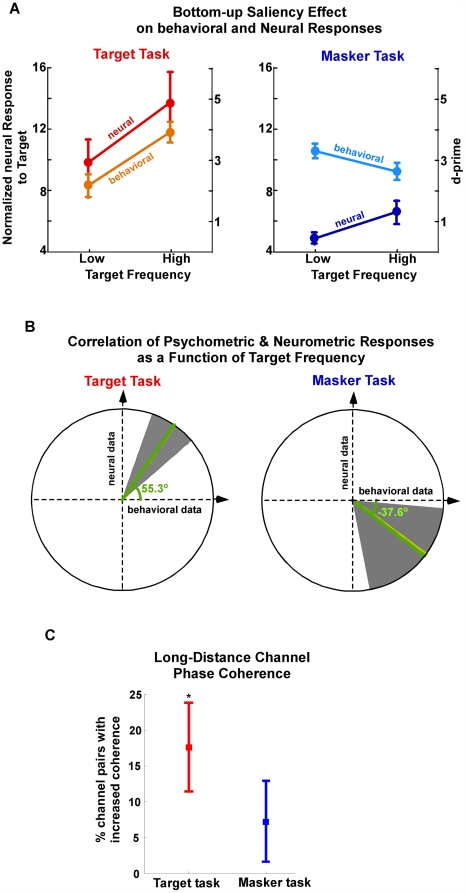
The effect of bottom-up acoustic saliency on behavior and neural responses.(A) Normalized neural response to target rhythm, and behavioral performance, as a function of target frequency in target task (left) and masker task (right), averaged over participants. Error bars represent standard error. (B) Correlation of behavioral and neural responses as a function of target frequency. The ratio of the neural to behavioral response differences as a function of target frequency, interpreted as a slope angle, is averaged across participants yielding a mean slope angle of 55.1° for target (left) task and −36.3° for masker (right) task (yellow line). Bootstrap estimates (overlying green lines) and their 95% confidence intervals (gray background) confirm the positive (respectively, negative) correlations for target (respectively, masker) task. (C) Phase coherence between distant MEG channels of target relative to masker task for high-frequency targets over low-frequency targets. High- versus low-frequency targets show significant enhancement only for target task (indicated by the asterisk).